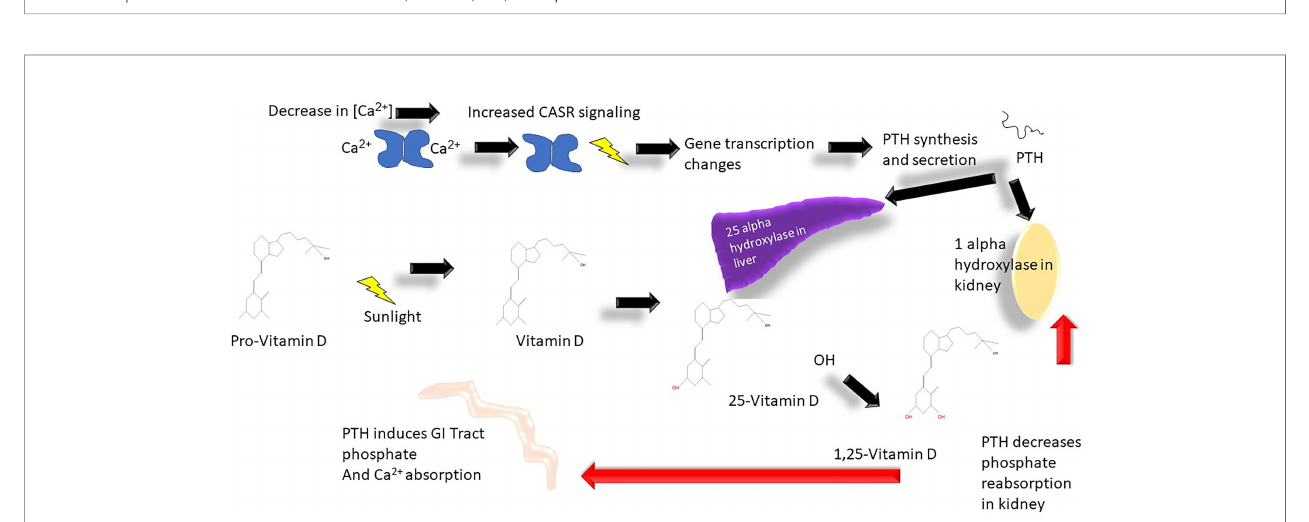
FIGURE 2 | Calcium metabolism vitamin D cycle: Ca 2+ , calcium; CASR, calcium sensing receptor; OH - , hydroxyl